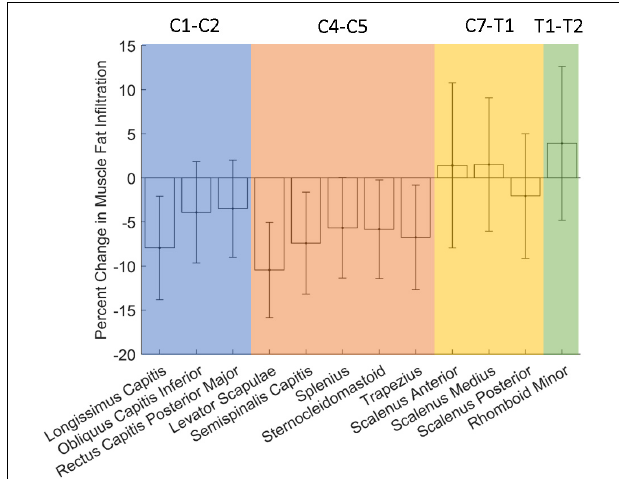
FIGURE 5 | Changes in neck MFI with long-duration spaceflight. Error bar denotes standard